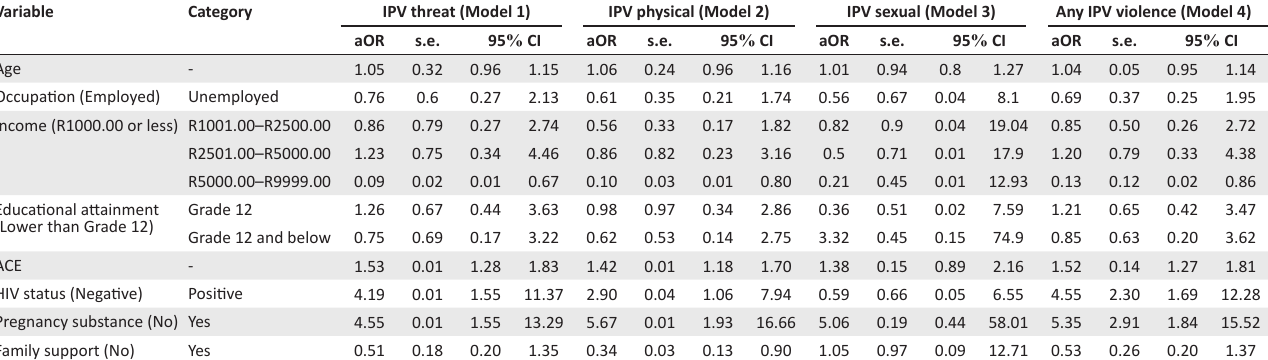
TABLE 2: Regression on the role on the roles of adverse childhood experiences, HIV and substance use during pregnancy on intimate partner violence (threat, physical, sexual, any) outcomes. Variable